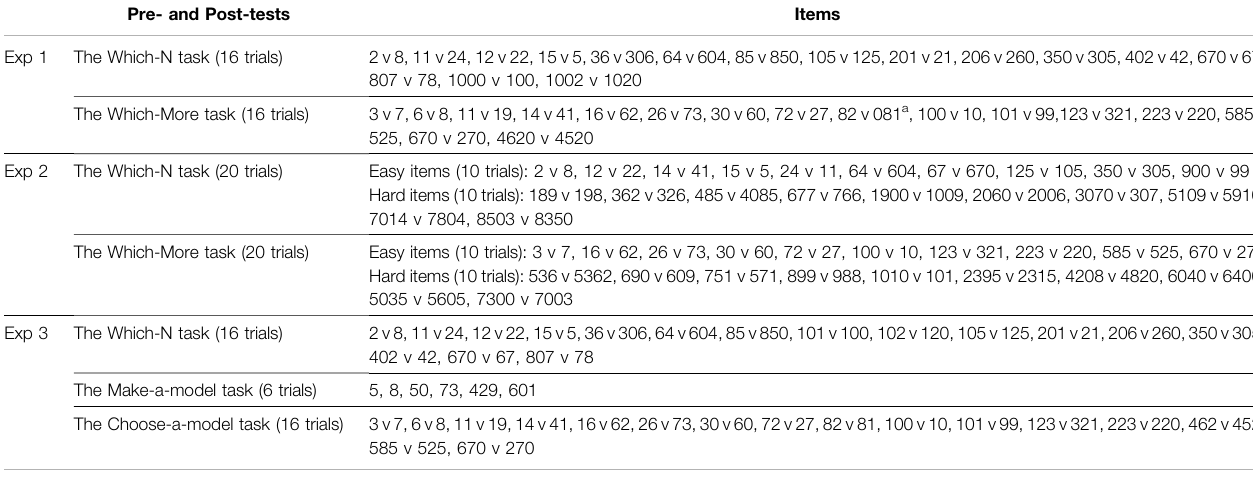
TABLE 1 | All tasks and items used in the three